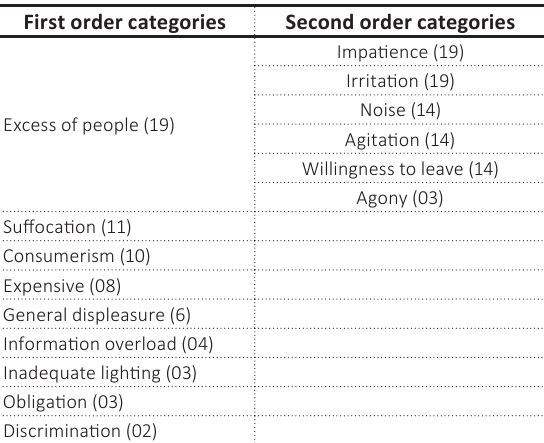
Table 1. Subcategories of Unpleasant